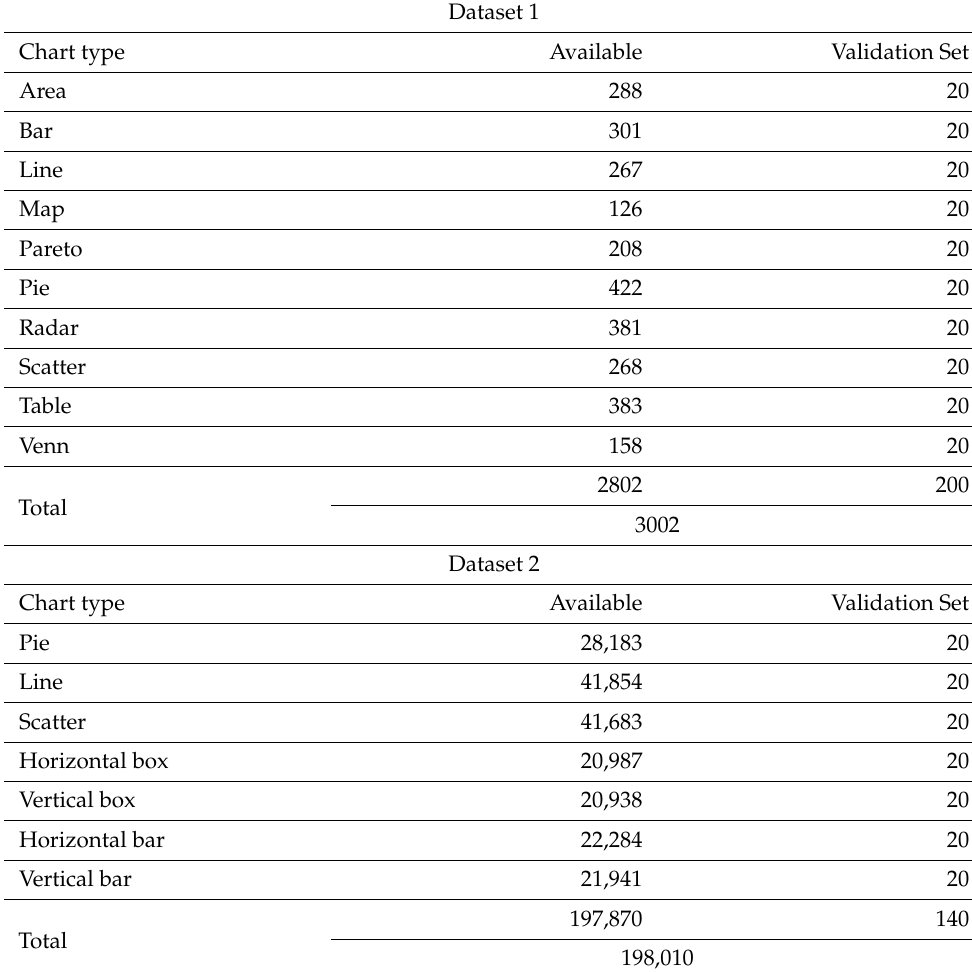
Table 2. The total number of images in each dataset after excluding the validation